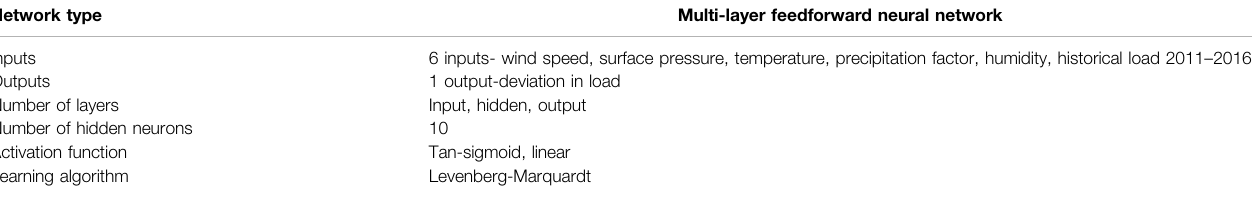
TABLE 1 | Summary of arti fi cial neural network design and architecture for forecasting load deviation. Network